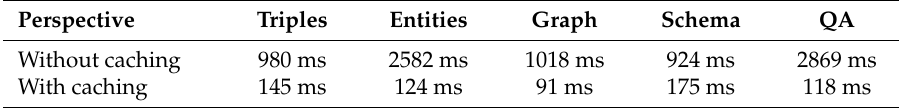
Table 2. Average load times for each